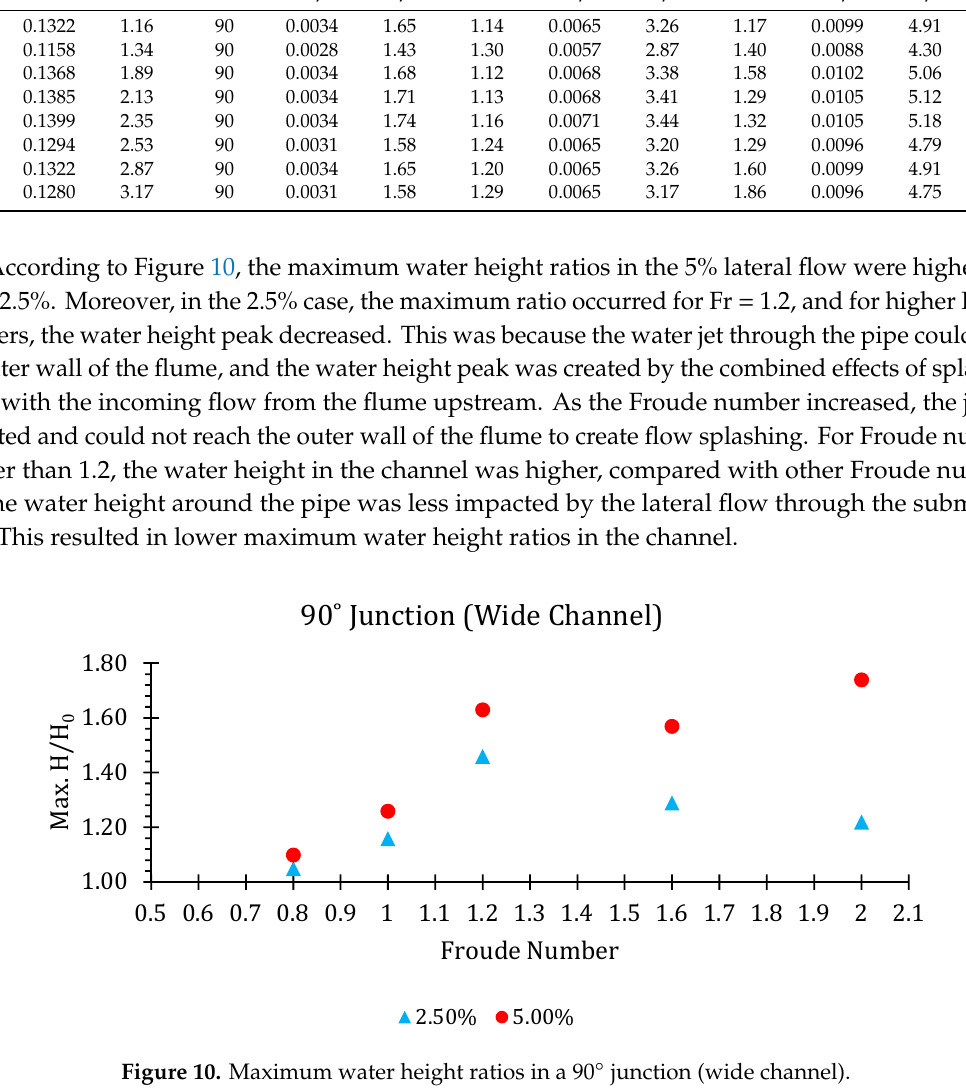
Figure 11. Maximum water height ratios in a 90° junction (narrow channel).